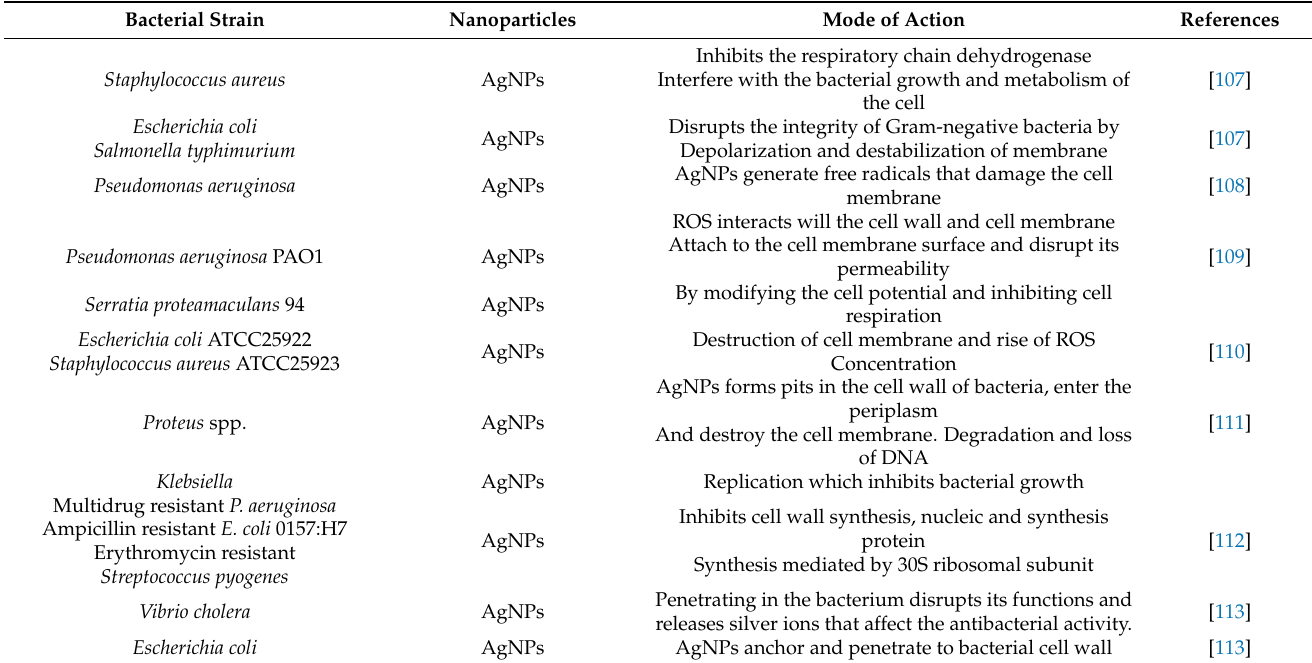
Table 2. Selected studies of NP’s mode of action against Gram-positive and Gram-negative